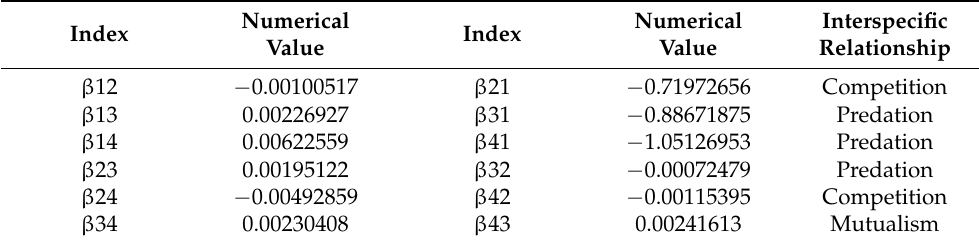
Table 12. The relationship between forecasting data systems in Tianjin